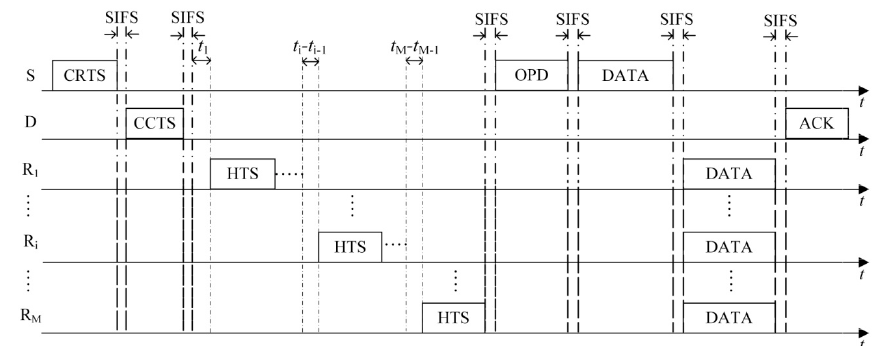
Figure 2. Packet transmissions of power-optimized cooperative MAC (PO-CMAC) protocol.